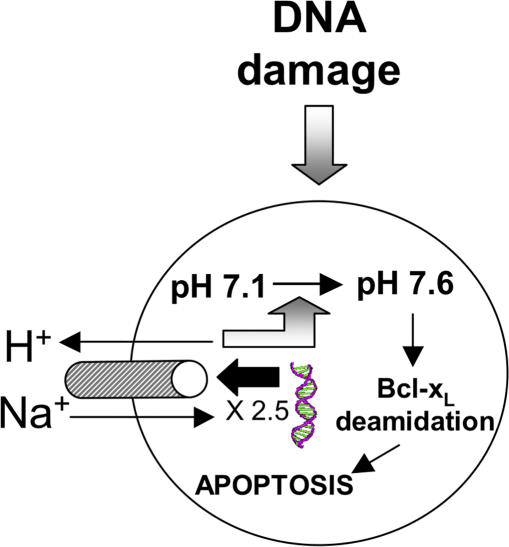
A novel signaling pathway triggered by DNA damage leads to the upregulation of the NHE-1 antiport, increased intracellular pH, Bcl-xL deamidation, and finally apoptosis.